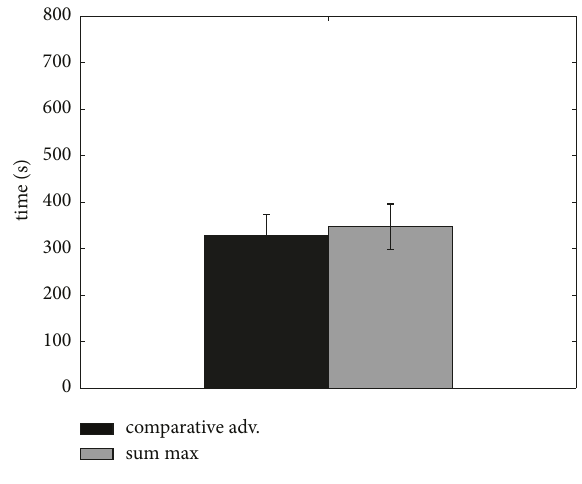
Figure 12: Makespan in 100